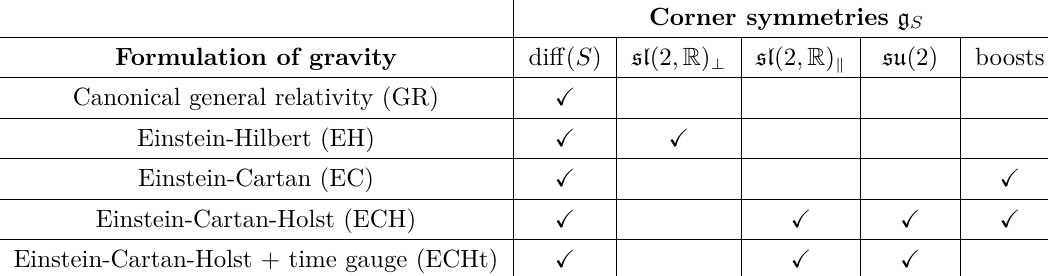
Table 1 . Parts of the corner symmetry algebra which are non-trivially represented in various formulations of gravity. The sl (2 , R ) algebras denoted with ⊥ and k are respectively associated with the metric components which are normal and tangent to the corner. The last two columns are the decomposition of the Lorentz algebra into boosts and